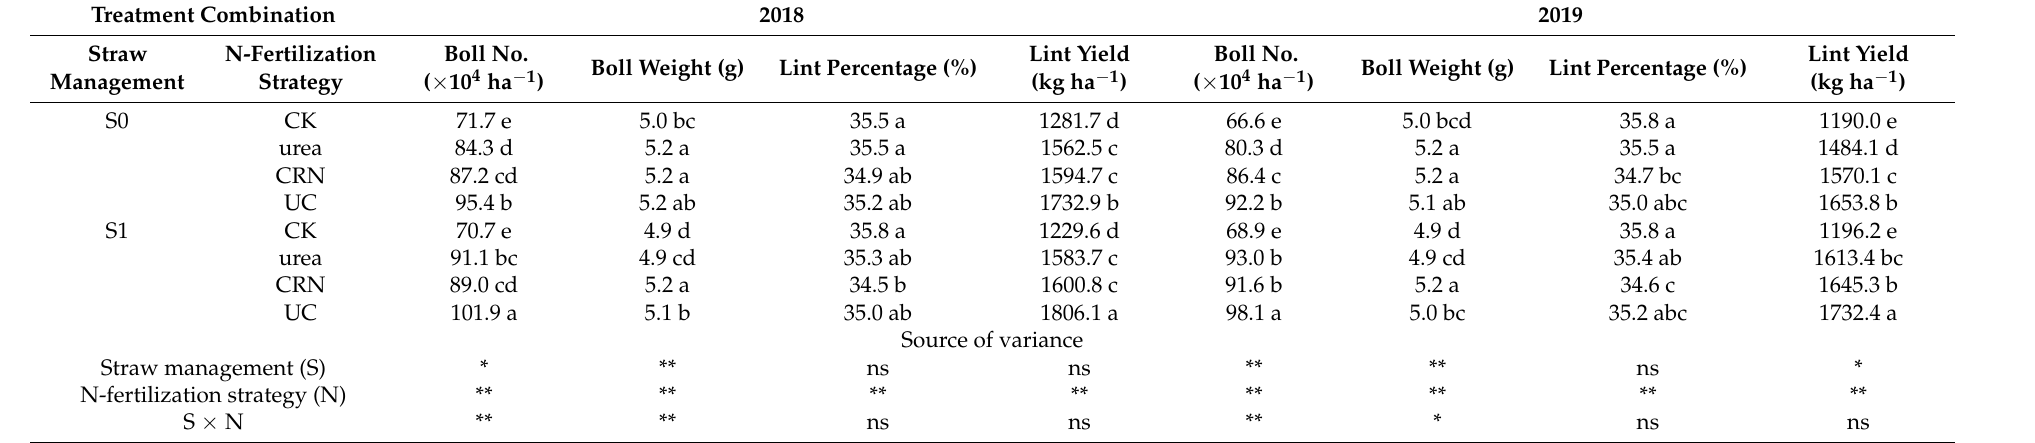
Table 1. Effects of straw management combined with N-fertilization strategy on lint yield and yield components in field-seeded